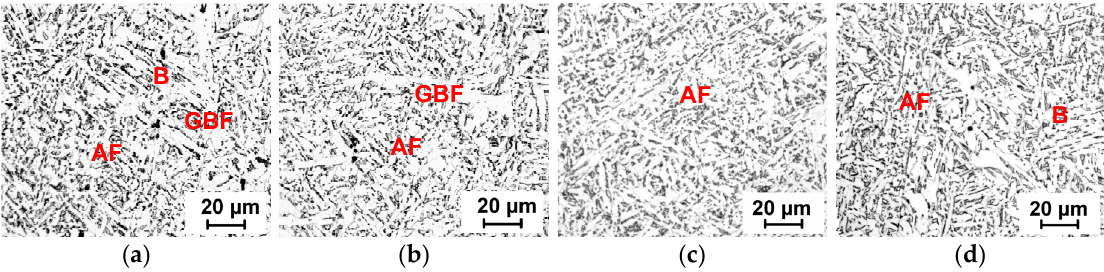
Figure 9. Optical microstructures formed with different holding times at 1250 °C: ( a ) 1 min, ( b ) 5 min, ( c ) 30 min, ( d ) 60 min. AF: Acicular ferrite; GBF: Grain boundary ferrite; B: